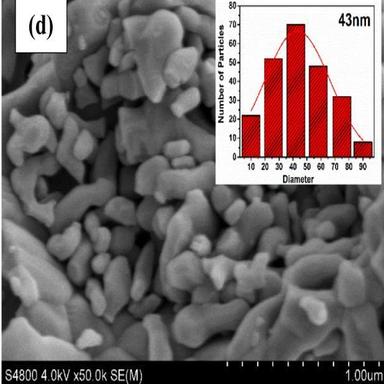
(a-d, a′-d′): SEM images, and histograms of Mg1-xCoxFe2O4 with (x = 0, 0.03, 0.06, and 0.09) nanoparticles and (a′-d′) EDX spectra of Mg1-xCoxFe2O4 with (x = 0, 0.03, 0.06, and 0.09) nanoparticles.